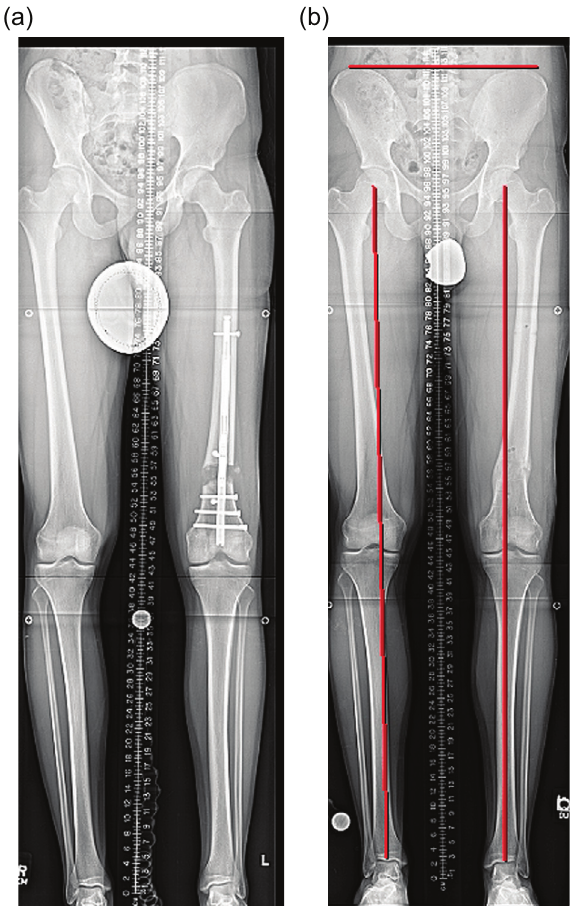
Figure 7. (a) The lengthening is complete and the limb length is checked. The regenerate bone is filling in but is still plastic enough to allow for fine-tuning of the length. The long-standing X-ray can be affected by hip and knee joint muscle contractures yielding a false length measurement. This needs to be considered before over- lengthening the limb. (b) The final alignment and length are checked after ILN removal.